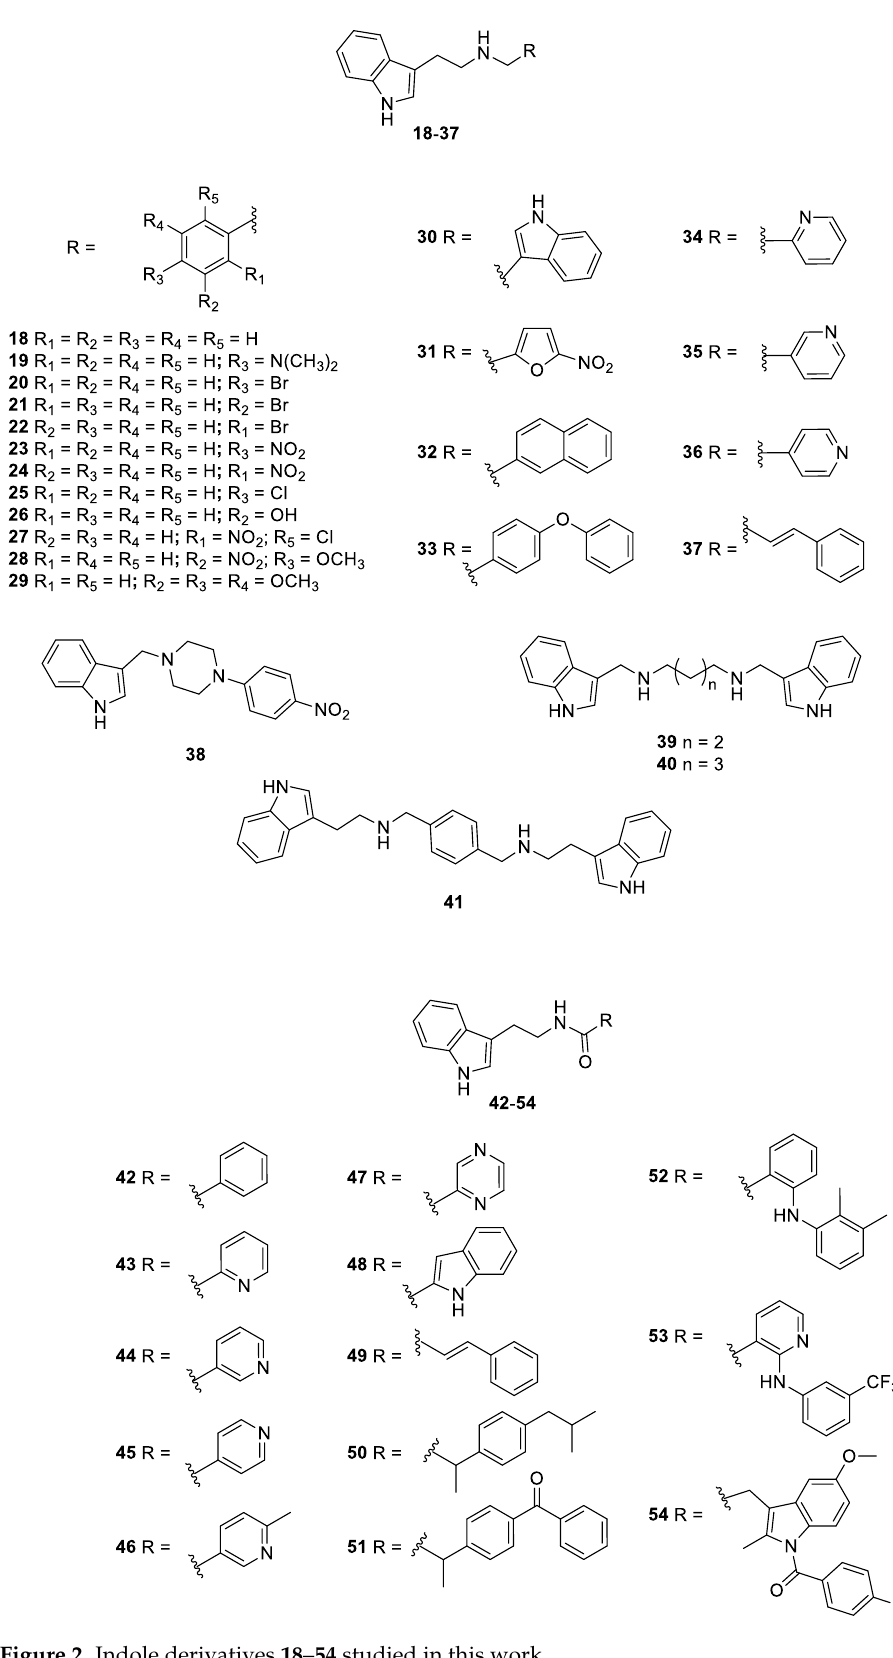
Figure 2. Indole derivatives 18 – 54 studied in this work.